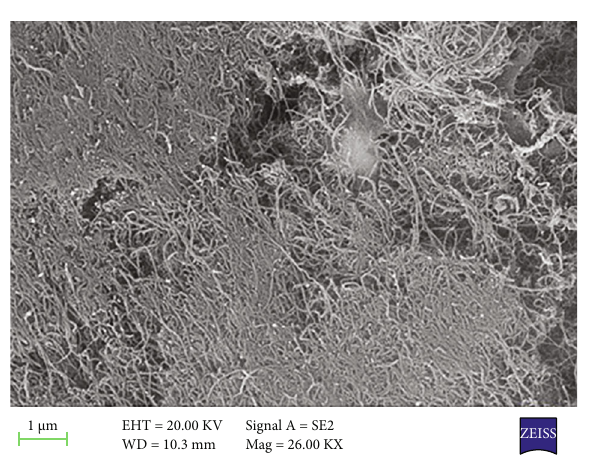
Figure 5: Microstructural analysis of CNTs.